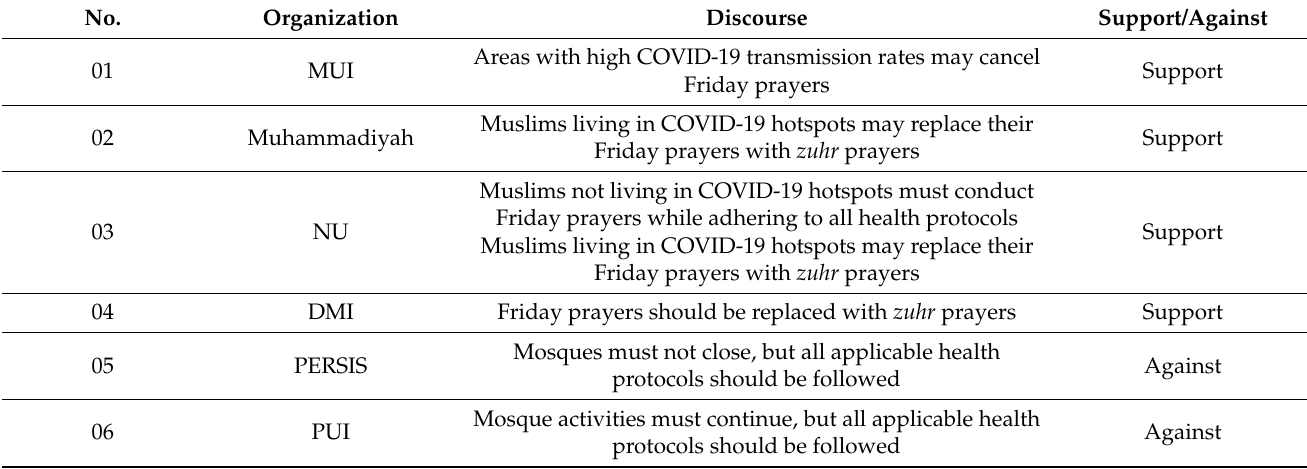
Table 3. Organizational Responses to Worship Restrictions during the COVID-19